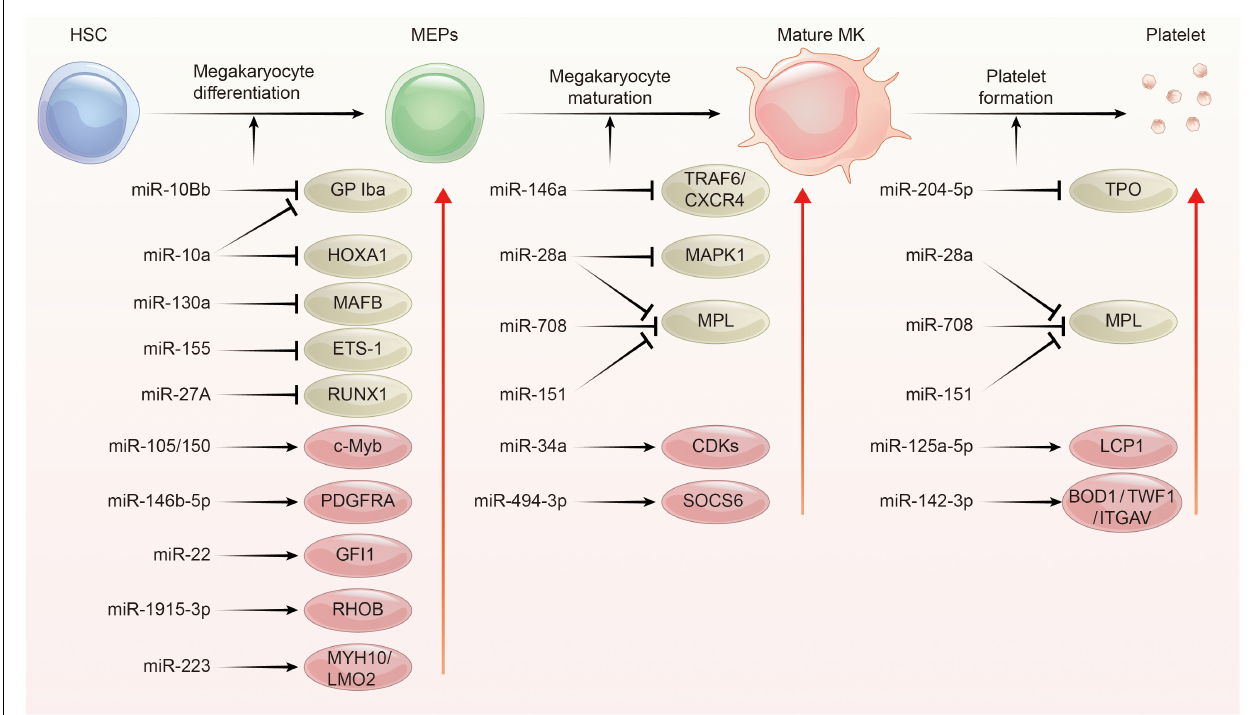
FIGURE 2 | The regulation network of miRNA during platelet biogenesis. Platelet production goes through three main stages: Firstly, hematopoietic stem cells (HSCs) were differentiated into megakaryocyte erythroid progenitor cells (MEPs), which were further differentiated and proliferated to form mature megakaryocytes, and then produced functional platelets. This process is controlled by several miRNAs through regulating the expression of their target gene. The red circle represents miRNA-mRNA pairs promoting platelet biogenesis, and the brown color represents miRNA-mRNA pairs inhibiting this process. Abbreviations: GP Iba, glycoprotein Ib platelet subunit alpha; HOXA1, homeobox A1; MAFB, V-maf musculoaponeurotic fibrosarcoma oncogene homolog B; EST-1, E26 transformation-specific sequence 1; RUNX1, runt-related transcription factor 1; PDGFRA, platelet derived growth factor receptor alpha; GFI1, growth factor independent 1; RHOB, ras homolog family member B; MYH10, myosin heavy chain 10; LMO2, LIM-only protein 2; TRAF6, tumor necrosis factor receptor associated factor 6; CXCR4, C-X-C motif chemokine receptor 4; MAPK1, mitogen-activated protein kinase 1; MPL, thrombopoietin receptor; CDKs, cyclin dependent kinases; SOCS6, suppressor